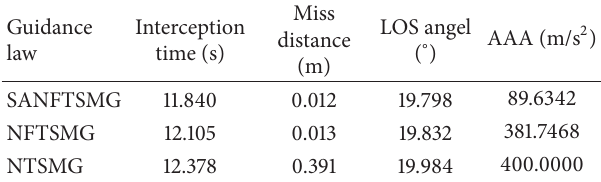
Table 4: Summary of simulation results in Case 3